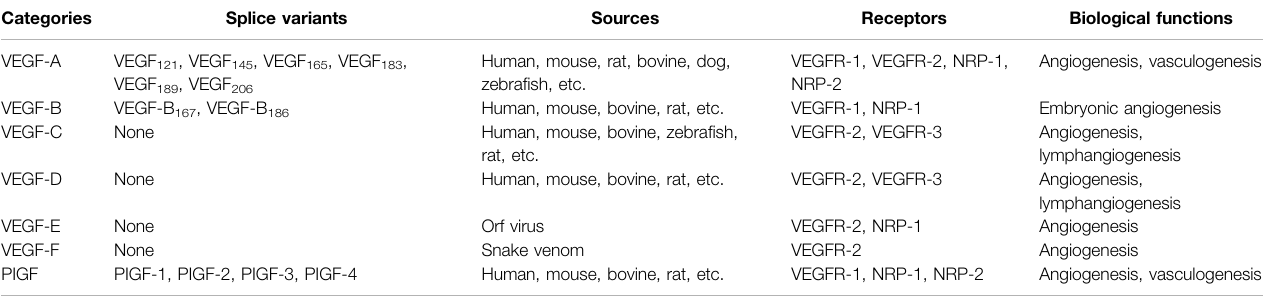
TABLE 2 | Members of the VEGF family and their biological functions.